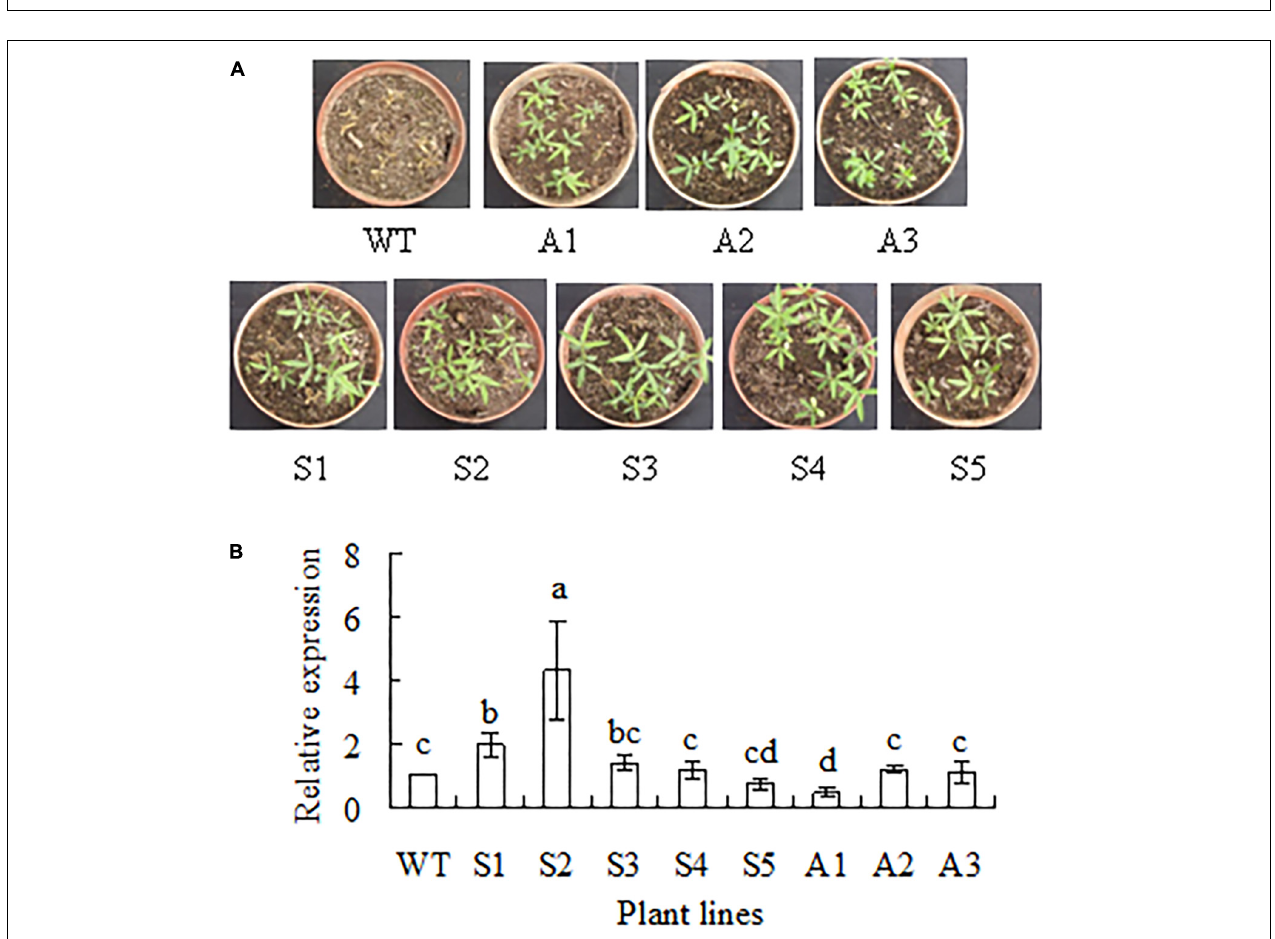
FIGURE 3 | Basta resistance and relative expression of SgCP12 in transgenic plants overexpressing SgCP12 or down-regulating SgCP12 expression in comparison with the wild type ( S . guianensis cv. CIAT184). Two-week-old seedlings were sprayed with basta (60 mg l − 1 ) to select transgenic plants, and photography was taken 1 week after spraying with basta (A) . Relative expression was measured using quantitative RT-PCR, and actin was used as reference gene (B) . Means of three replicates and standard errors are presented; the same letter above the column indicates no significant difference among the tested plant lines at P < 0.05.